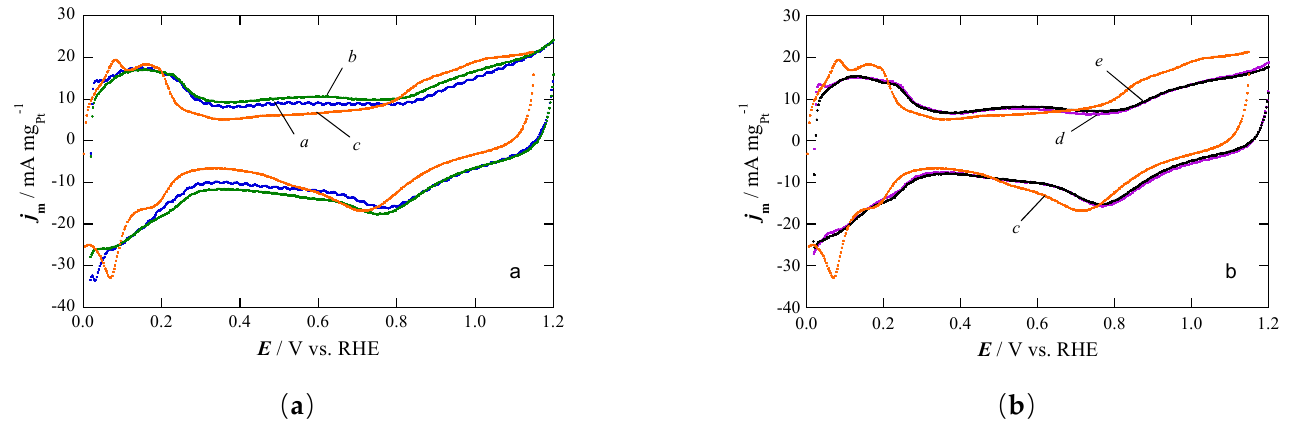
Figure 3. Cyclic voltammograms in deaerated 0.5 mol dm − 3 H 2 SO 4 solution at a scan rate of 20 mV s − 1 : ( a ) Pt(Cu)/CMK3 (curve a ), Pt(Cu)/CMK3-A ( b ), and Pt/C ( c ); ( b ) Pt(Cu)CMK8 (curve d ), Pt(Cu)/CMK8-A ( e ), and Pt/C ( c ). Table 3. Pt loadings for electrochemical testing, ECSAs measured from hydrogen desorption (H- des) and CO stripping (CO-des) and onset potentials for CO oxidation ( E CO ) in the corresponding cyclic voltammograms.